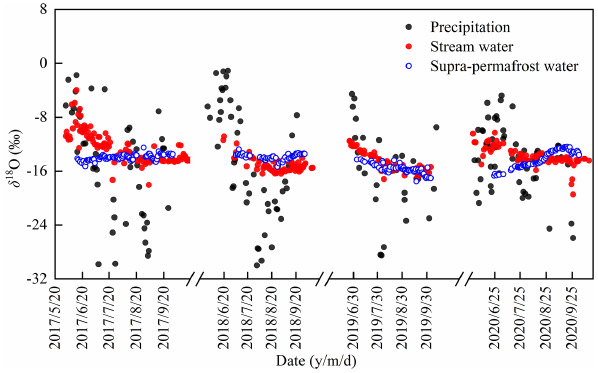
Figure 4. Comparison of variations in precipitation δ 18 O (‰) and stream and supra-permafrost water δ 18 O (‰) during the warm sea- sons from 2017 to